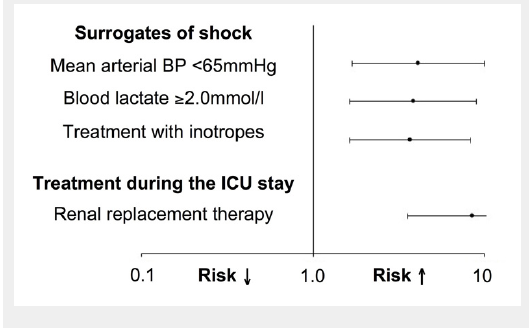
The figure shows risk factors associated with nosocomial infections during the ICU stay. Bars represent odd ratios with 95% confidence intervals. A value >1 indicates an increased risk for the occurrence of a nosocomial infection during the ICU stay. BP = blood pressure: ICU = intensive care